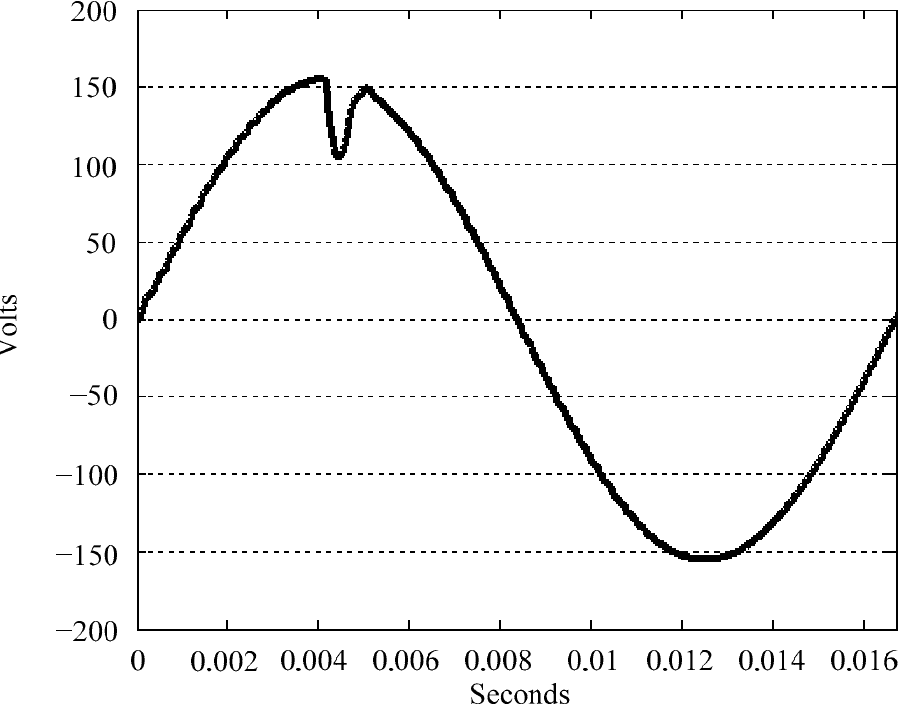
Figure 4. Simulated output voltage with the conventional SMC under stepped load.